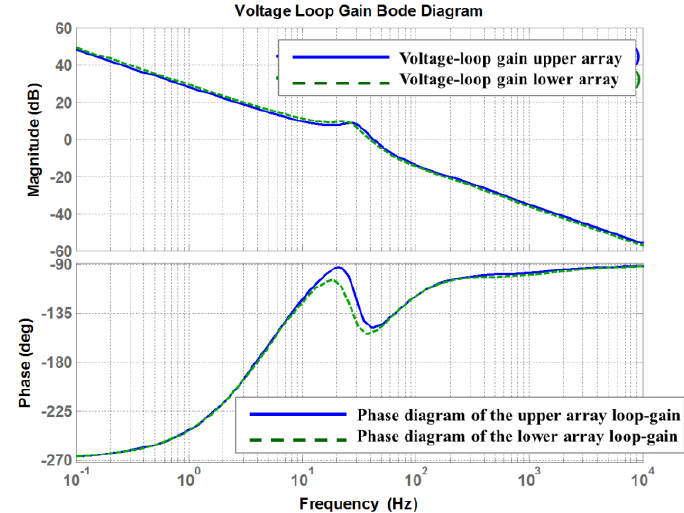
Figure 9. Voltage loop gain bode diagram of cascaded multilevel inverter system; Blue solid line is a voltage loop-gain bode diagram of the upper H-bridge module and a green dotted line is a voltage loop-gain bode diagram of the lower H-bridge module.